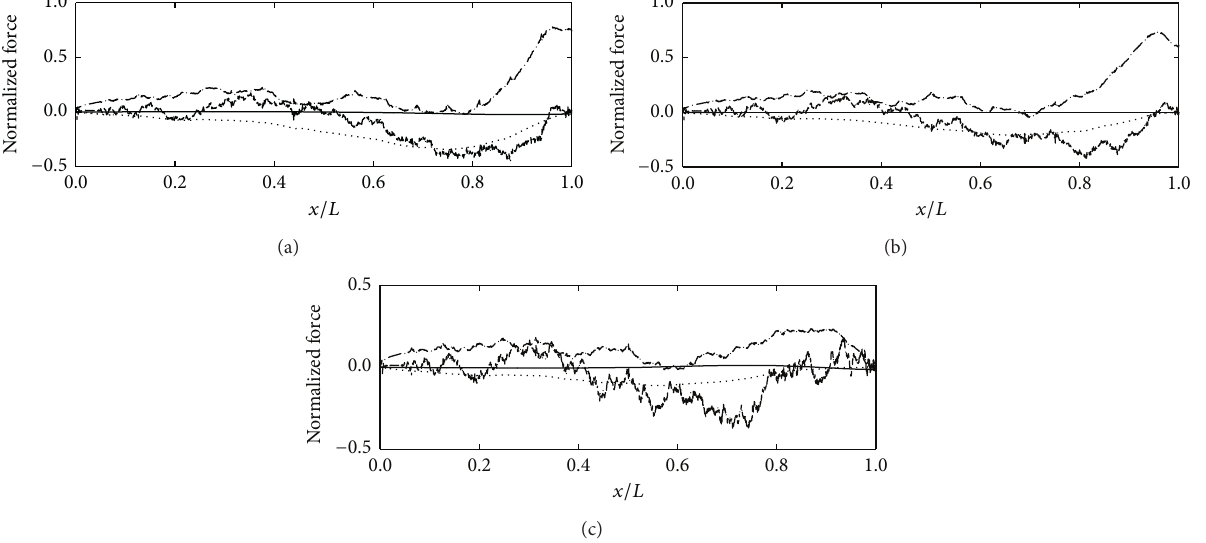
matrix; therefore, with Centrifugal force and inertia being neglected, both the amplitude and the phase are